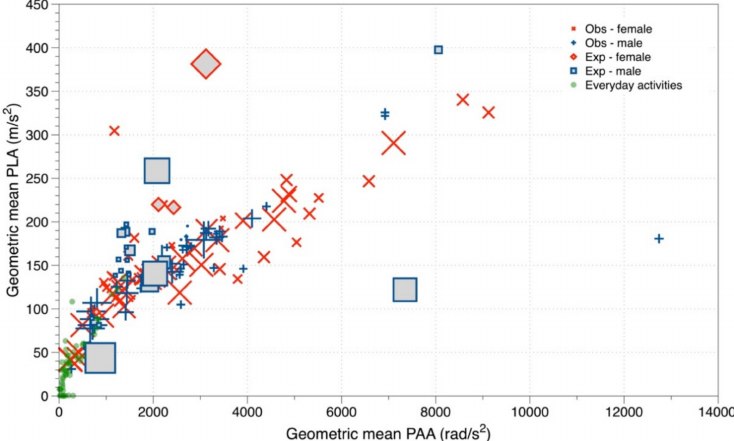
Figure 2. Scatter plot of mean peak linear and angular acceleration, by experimental (squares and diamonds) and observational (cross and plus) studies. Symbol area reflects the number of measurements associated with the